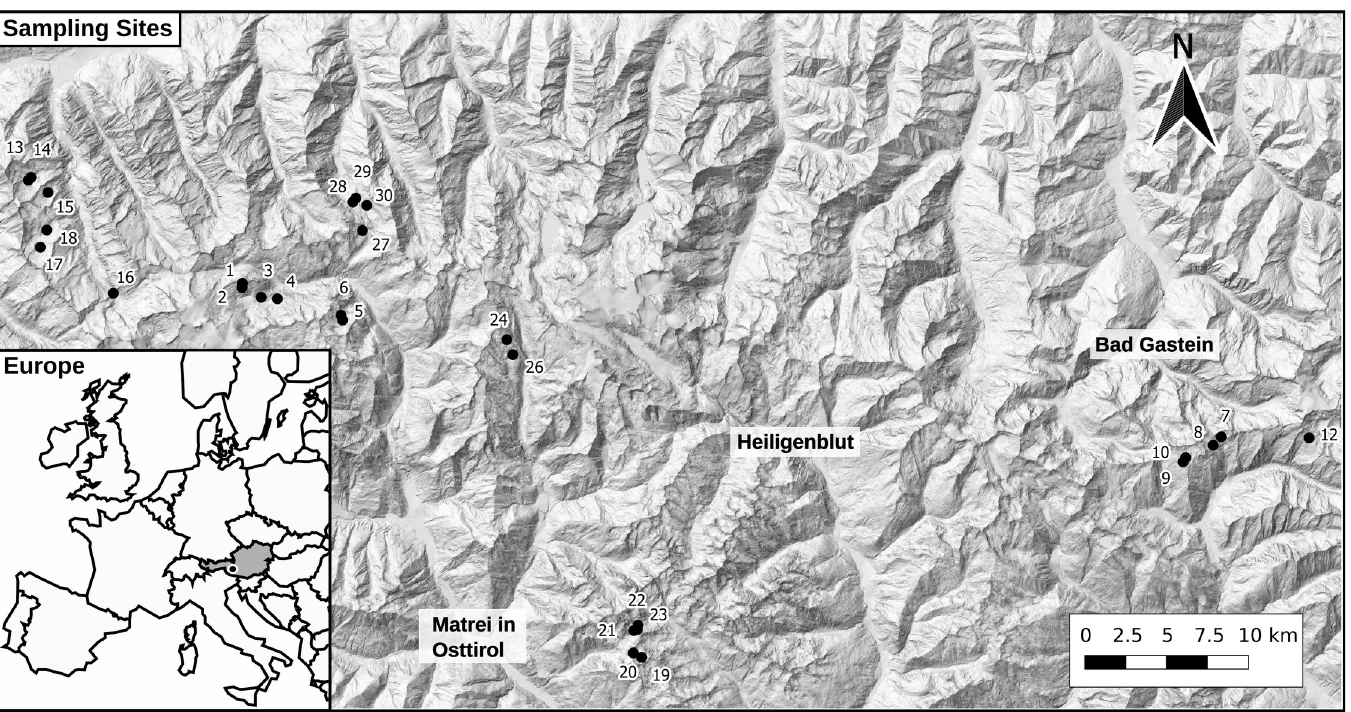
Fig 1. Sampled lakes in Hohe Tauern National Park. The map of Europe in the inset gives the location of Hohe Tauern National Park (black dot) in Austria (grey area)